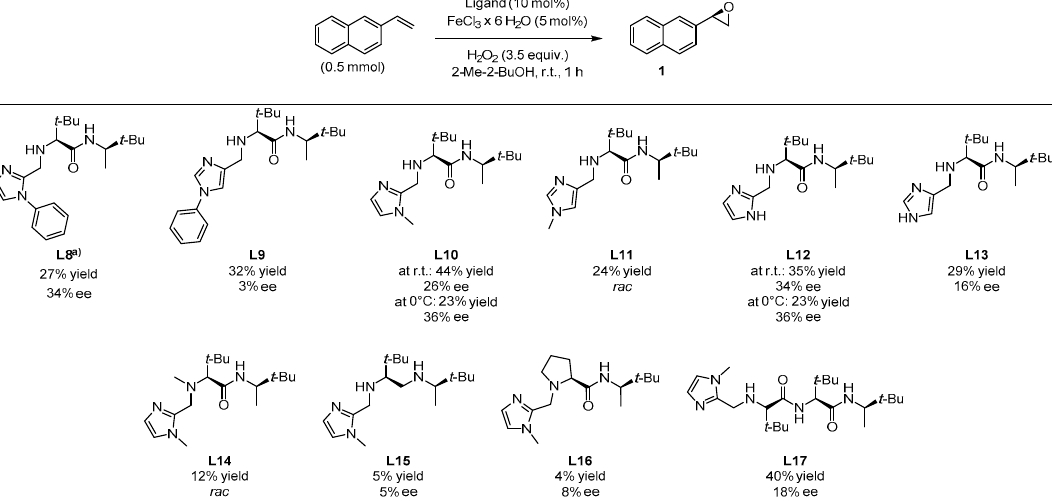
Table 1. Screening of chiral peptide-like imidazole-based ligands using ( S )-(+)-mandelic acid as additive.